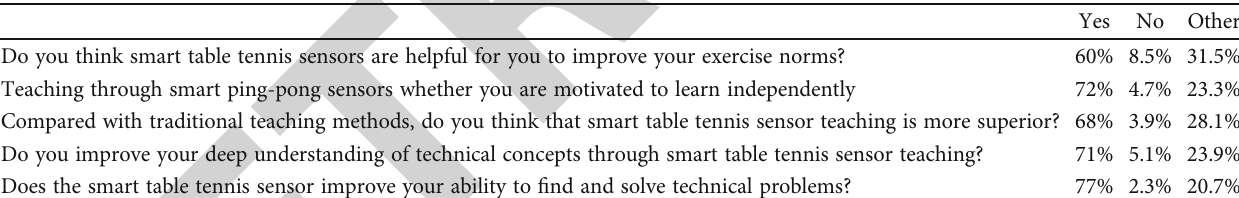
Table 2: Questionnaire on the use value of table tennis sensors.